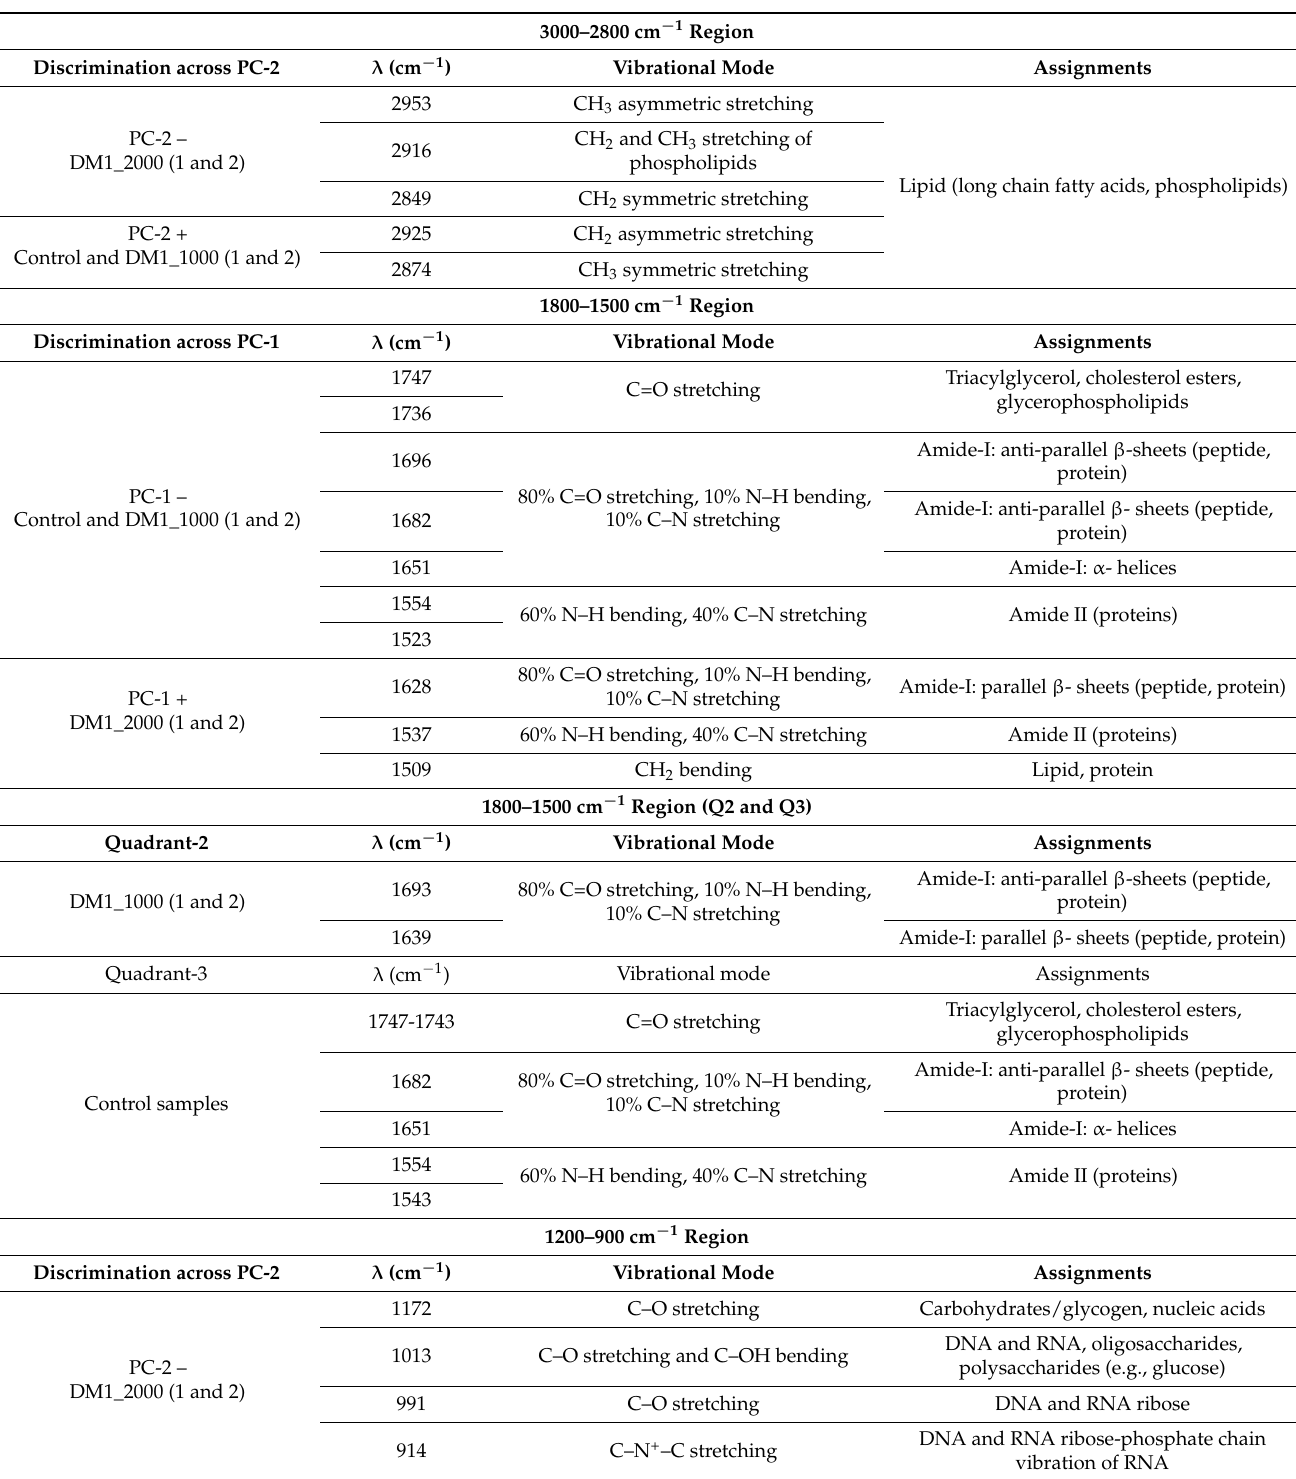
Table 1. DM1-derived fibroblast (Coriell Institute) and control spectroscopic signals, assignments and vibrational mode obtained by Principal Component Analysis (PCA) in the 3000–2800 cm − 1 , 1800–1500 cm − 1 and 1200–900 cm − 1 regions. Λ —Wavenumber; Q—Quadrant; − —Negative PC region; +—Positive PC region; DM1_2000 (1 and 2)—DM1_2000 (1)